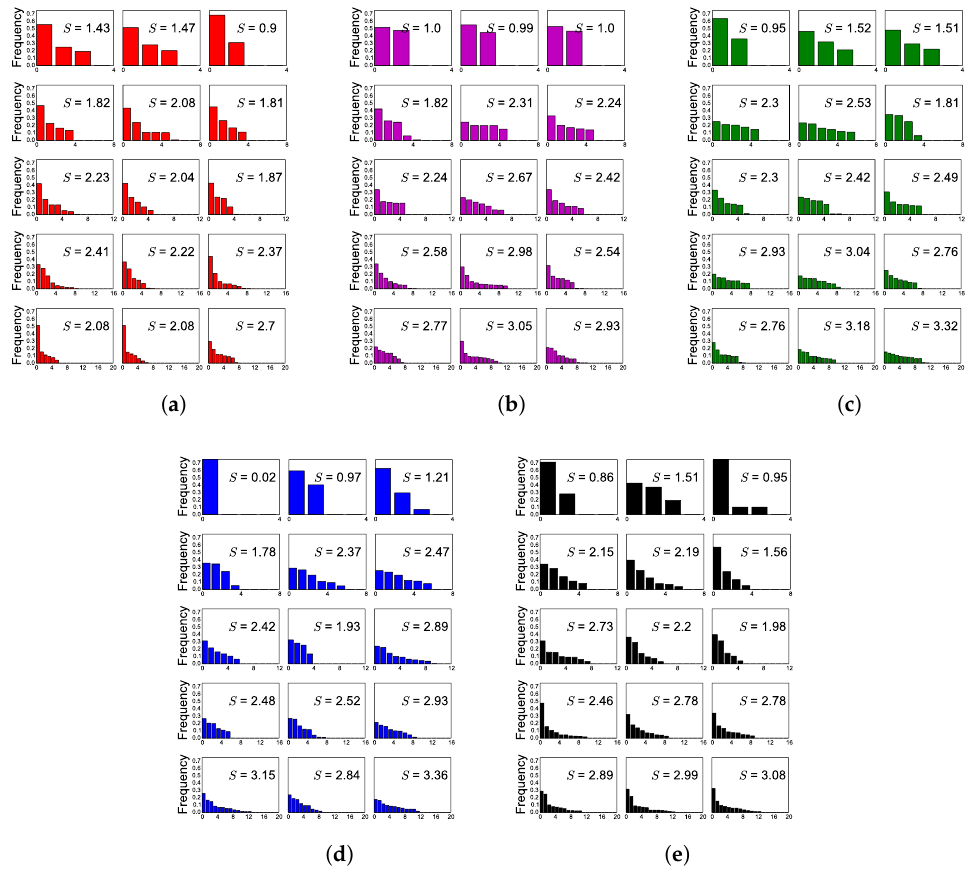
Figure 5. Activation by pathway for the different noise conditions. Only networks with maximum hypotheses of 4, 8, 12, 16, or 20 are shown. ( a ) no noise; ( b ) noise = 0.1; ( c ) noise = 0.25; ( d ) noise = 0.5; ( e ) noise = 1.